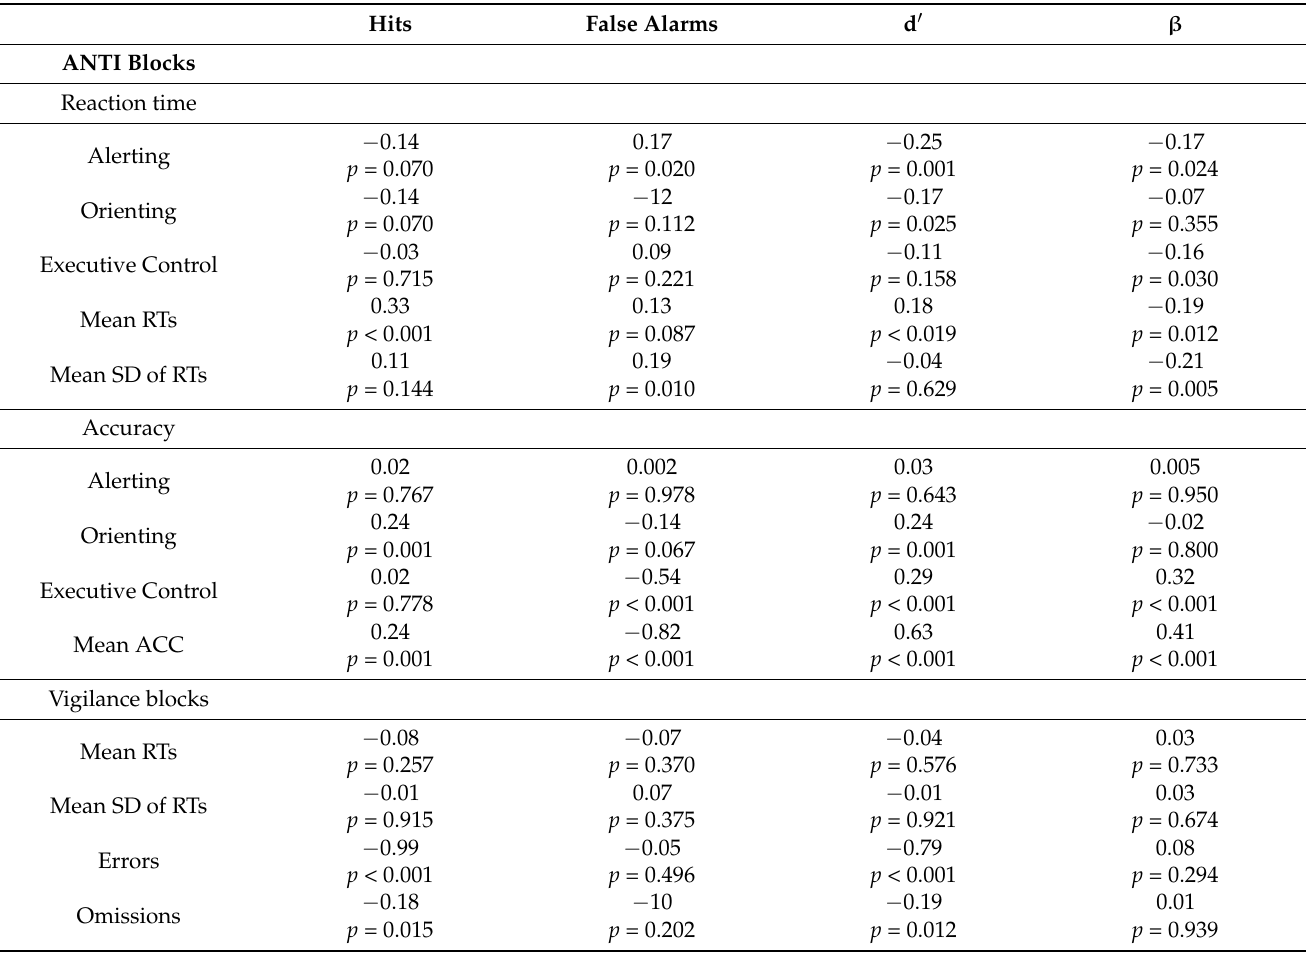
Table 3. Correlations between the signal detection theory indexes (hits, false alarms, d (cid:48) , and β ) and the attention networks scores, the mean reaction time, and the standard deviation of RTs (ANTI-blocks and vigilance blocks), the mean accuracy (ANTI-blocks), errors, and omissions (vigilance